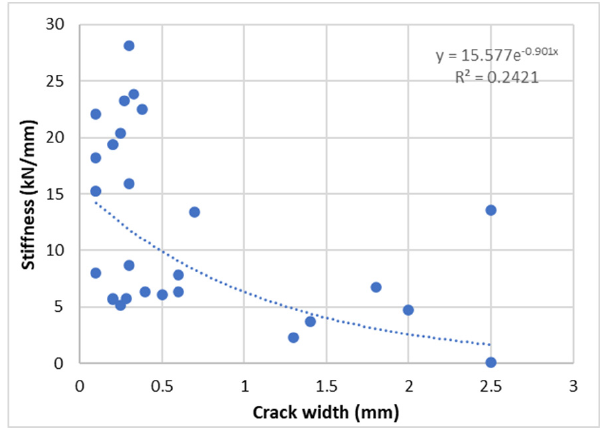
Figure 13. Stiffness of the linear branch of the load-displacement curves vs. crack width.